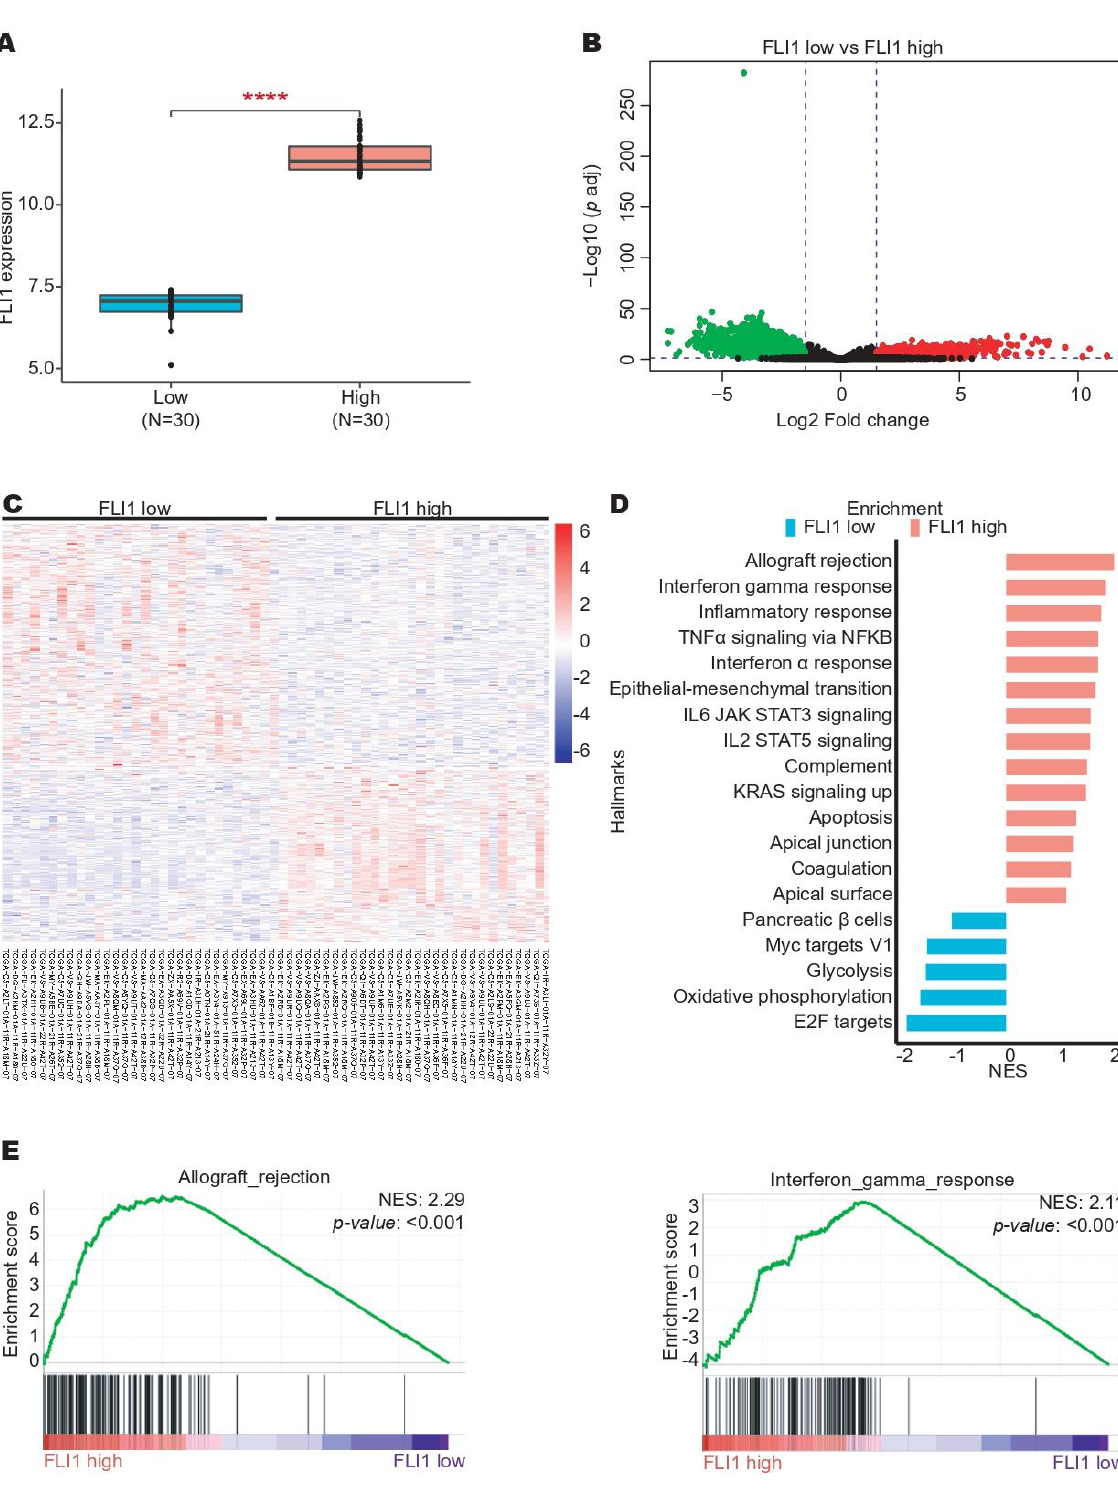
Figure 6. High FLI-1 expression is associated with pathways related to immune response in cervical cancer. ( A ) FLI-1 expression in CC patients with high FLI-1 expression (top 30) and low FLI-1 expression (top 30) from the TCGA dataset. ( B ) DEGs between the CC patients with low FLI-1 and high FLI-1 expression from the TCGA dataset. ( C ) Heatmap with DEGs from the TCGA dataset. ( D ) Identification of pathways enriched considering DEGs using GSEA software. ( E ) Two graphs representative of the GSEA analysis are shown. **** p -value < 0.0001.